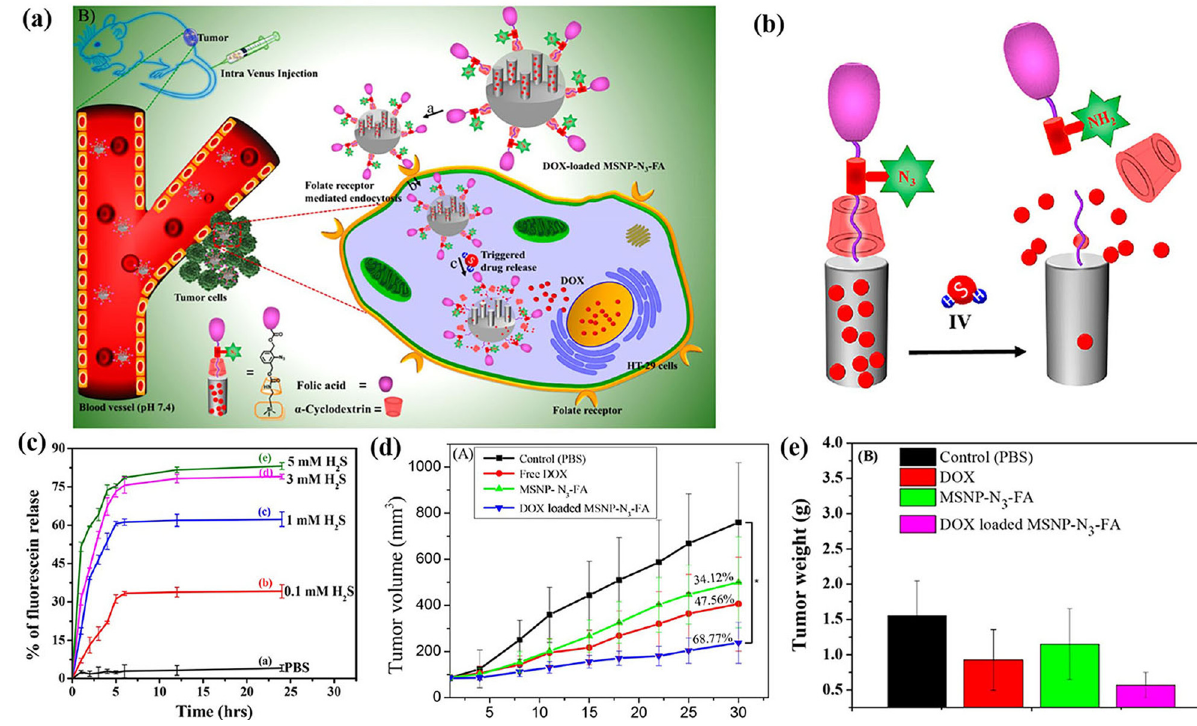
Figure 7: ( a ) Schematic illustration of the integration and release of DOX - loaded MSNP - N 3 - FA into HT - 29 cells. ( b ) H 2 S - triggered drug release. ( c ) Fluorescein release from MSNP - N3 - FA in di ff erent H 2 S concentrations. ( d ) Tumor growth curves after intra - arterial injection of PBS, free DOX, MSNP - N 3 - FA, and DOX - loaded MANP - N 3 - FA. ( e ) Changes in tumor weight in di ff erent treatment groups. Reprinted with permission from Ref. [ 107 ] ; Copyright © 2019 American Chemical